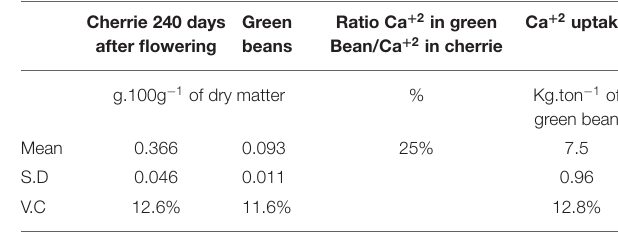
TABLE 5 | Calcium concentration in cherries (including beans, husk, pulp, and mucilage) and in green beans, and the estimation of Ca uptake per ton for Coffea arabica L. cv. Castillo ® .